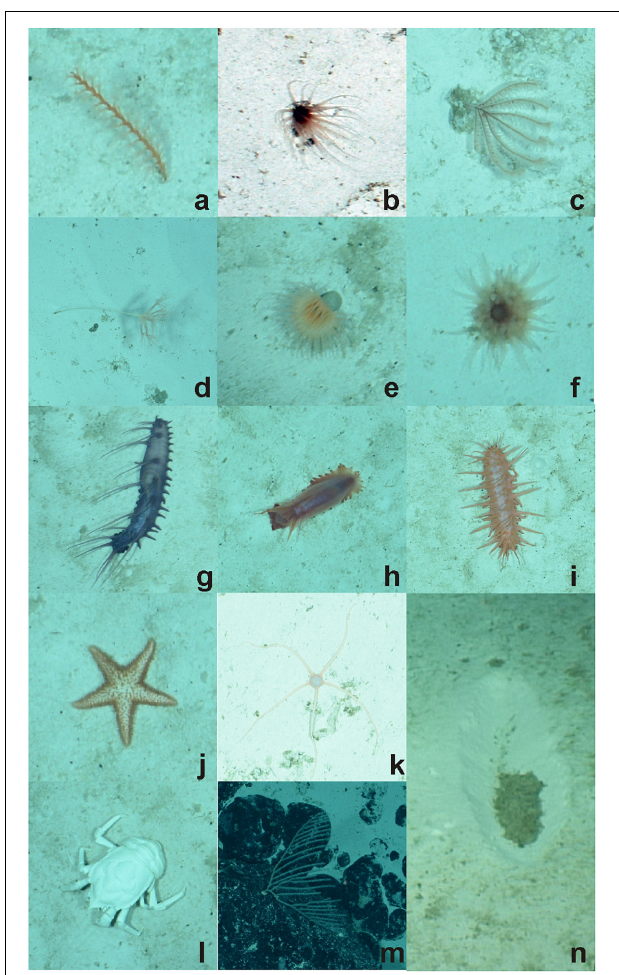
FIGURE 3 | Select invertebrate megafaunal specimens photographed on the seamount study areas in the western CCZ: Cnidaria (a) Protoptilum sp. PEN017, (b) Cerianthidae CER001, (c) Heteropathes cf. americana ALC021, (d) Umbellula sp. PEN012 with ripples in sediment, (e) Actiniaria ACT043, (f) Actiniaria ACT012; Holothuroidea: (g) Laetmogone sp. HOL030, (h) Peniagone sp. HOL064, (i) Deimatidae HOL060; (j) Asteroidea AST024; (k) Ophiuroidea OPH012; (l) Galatheoidea DEC007, (m) Actiniaria ACT011 on basalt-type hard substrate, (n) large depression in soft sediment ( ∼ 0.5 × 1.5 m). Image attribution: JM Durden and CR Smith, University of